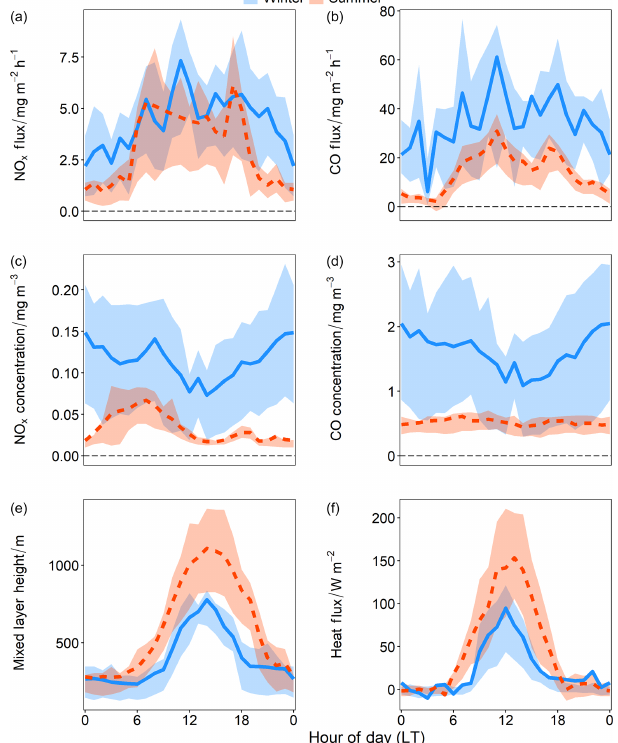
Figure 5. Average diurnal profiles for (a) NO x flux, (b) CO flux, (c) NO x concentration, (d) CO concentration and (e) mixed layer height and (f) heat flux. Blue, solid lines are for measurements taken during the winter campaign and the orange, dashed lines are mea- surements taken during the summer campaign. The shaded areas represent the 25th and 75th percentiles. For the NO x and CO fluxes, only stationary data have been used, but no u ∗ filtering has been ap- plied when doing the diurnal averaging, as described in Sect.